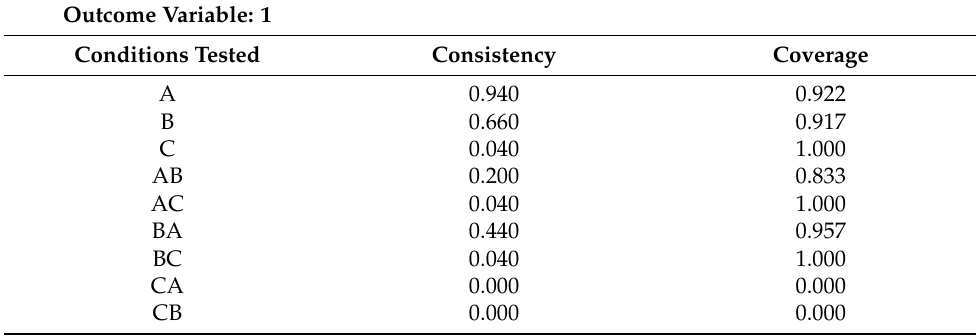
Table 8. Results of necessity tests (Hazard #3).